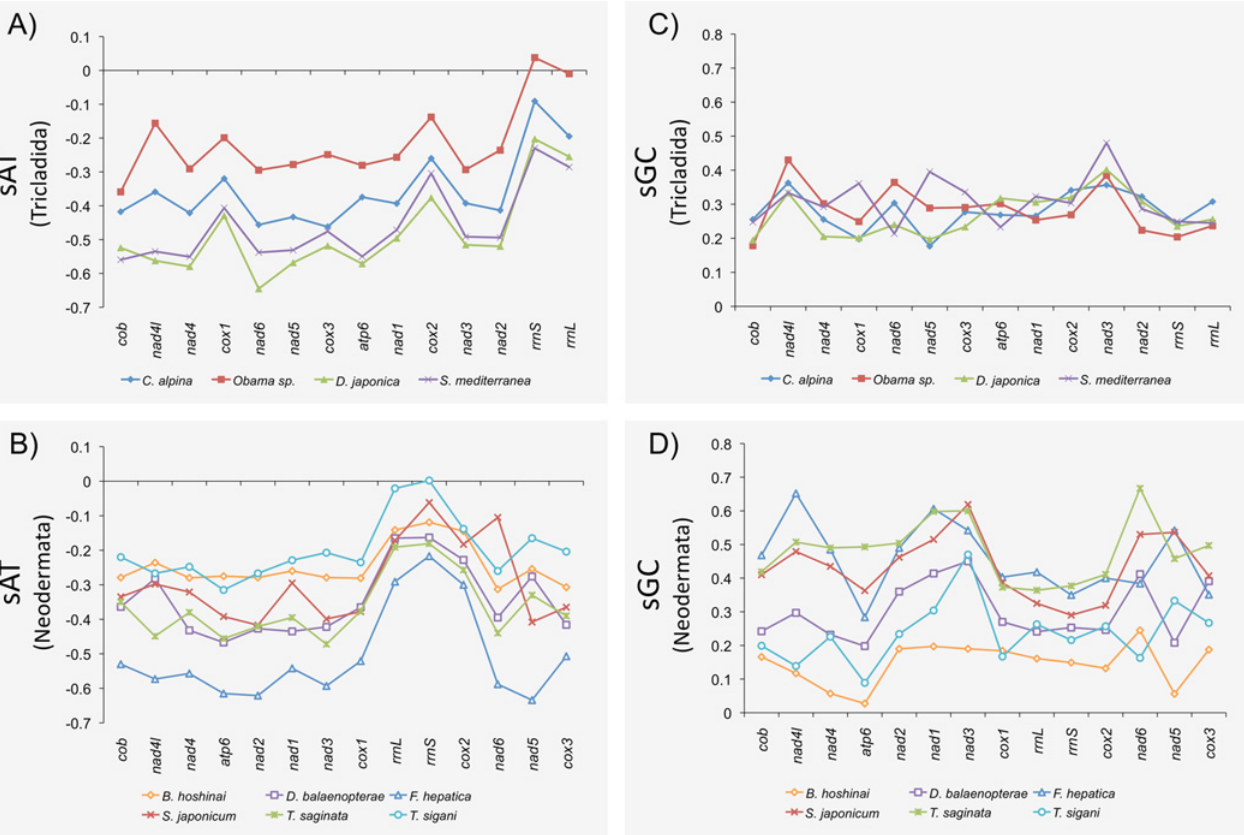
Fig 4. sAT and sGC values of the protein coding genes (PCG) along the mtDNA molecule. A) sAT of Tricladida; B) sAT of Neodermata; C) sGC of Tricladida; D) sGC of Neodermata.